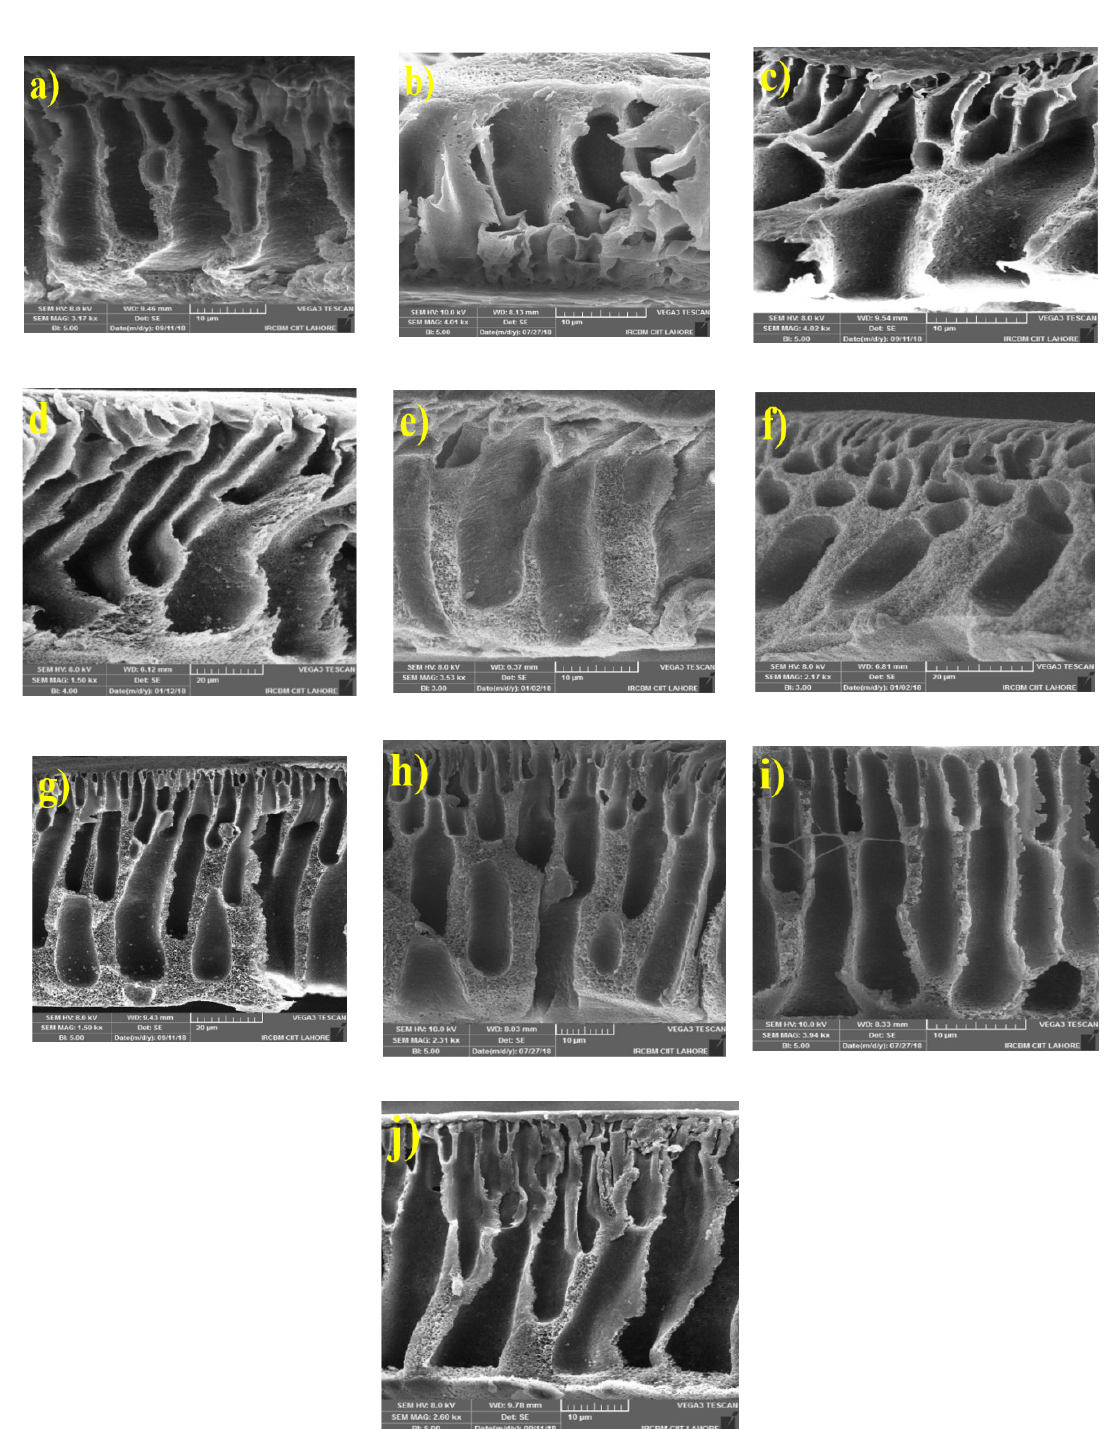
Figure2. CrosssectionSEMimagesofmembranes( a )NeatPSfmembrane;( b – d )PSf / Zeolite4Amembranes; Figure 2. Cross section SEM images of membranes ( a ) Neat PSf membrane; ( b – d ) PSf/Zeolite 4A ( e – g ) PSf / UiO-66 membranes; ( h – j ) PSf / Zeolite 4A-UiO-66 membranes with different nanofiller loadings membranes; ( e – g ) PSf/UiO-66 membranes; ( h – j ) PSf/Zeolite 4A-UiO-66 membranes with different (0.5 wt%, 1 wt%, 2 wt%,